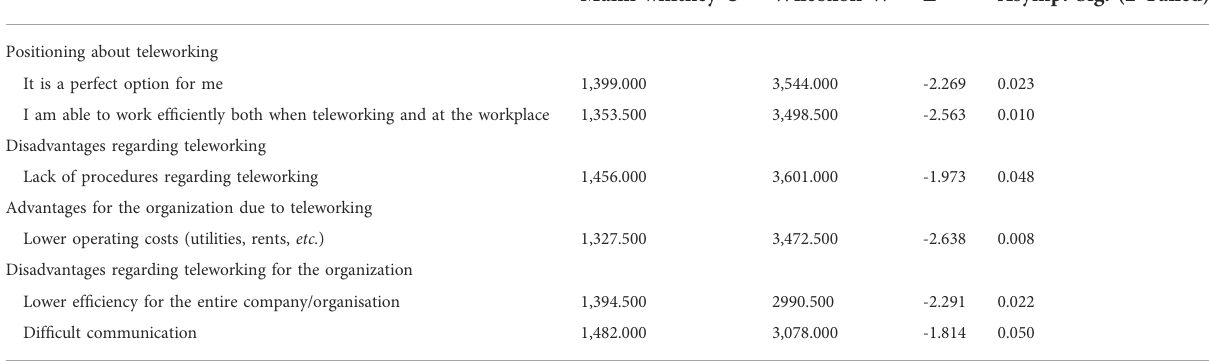
TABLE 7 Results of the Mann — Whitney U test for management